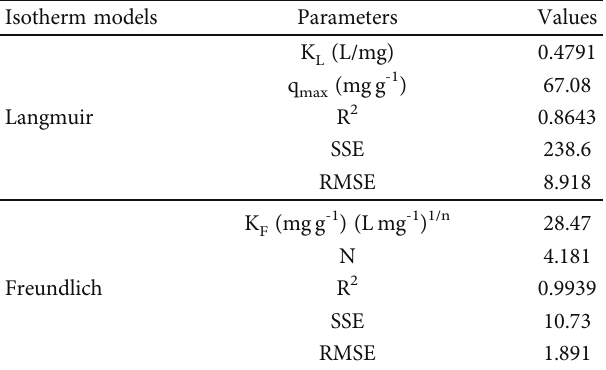
Table 3: Isotherm